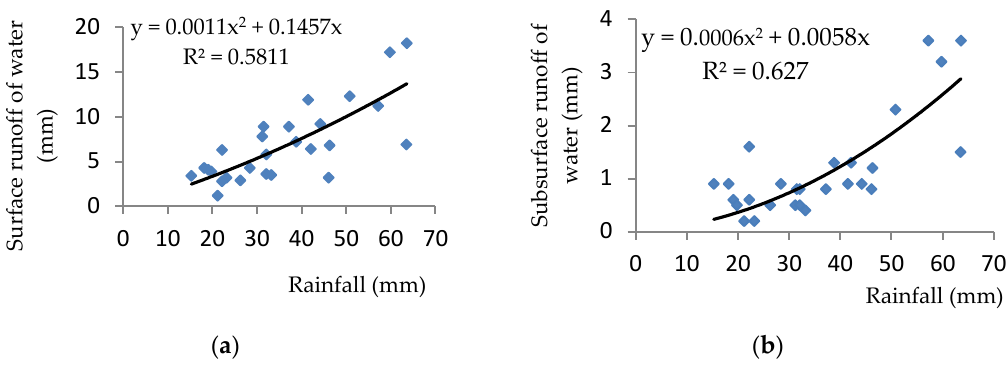
Figure 4. Surface runoff of water ( a ) and subsurface runoff of water ( b ) in dependence on the rainfall amount.